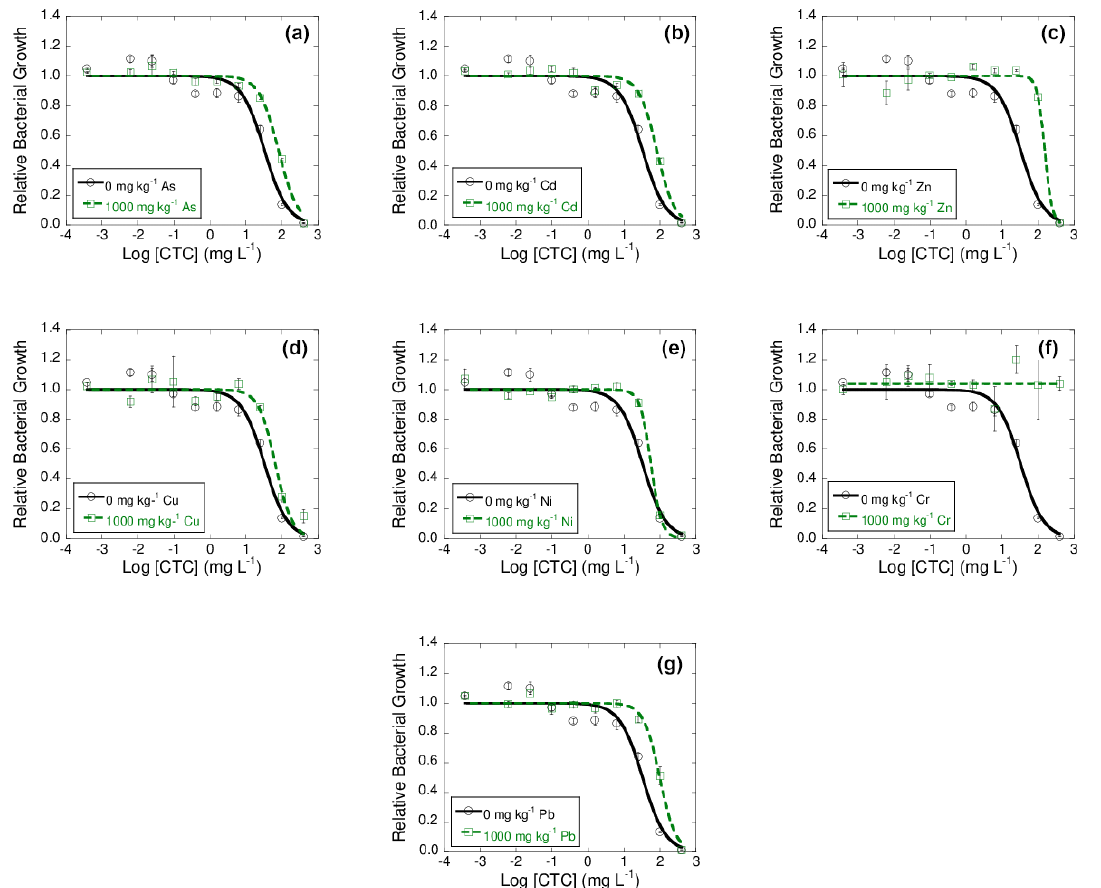
Figure 4. Dose–response curves obtained after the addition of 10 different concentration of chlortetracycline (CTC) to bacterial suspension extracted from soil samples polluted with 1000mgkg − 1 of As (a) , Cd (b) , Zn (c) , Cu (d) , Ni (e) , Cr (f) , or Pb (g) , each of them added separately, after 42d of incubation. Black lines represent the dose–response curves obtained for the unpolluted soil (control), and dashed green lines are dose–response curves for soils polluted with 1000mgkg − 1 of one of the heavy metals. Average values ( n = 3) with coefficients of variation always <